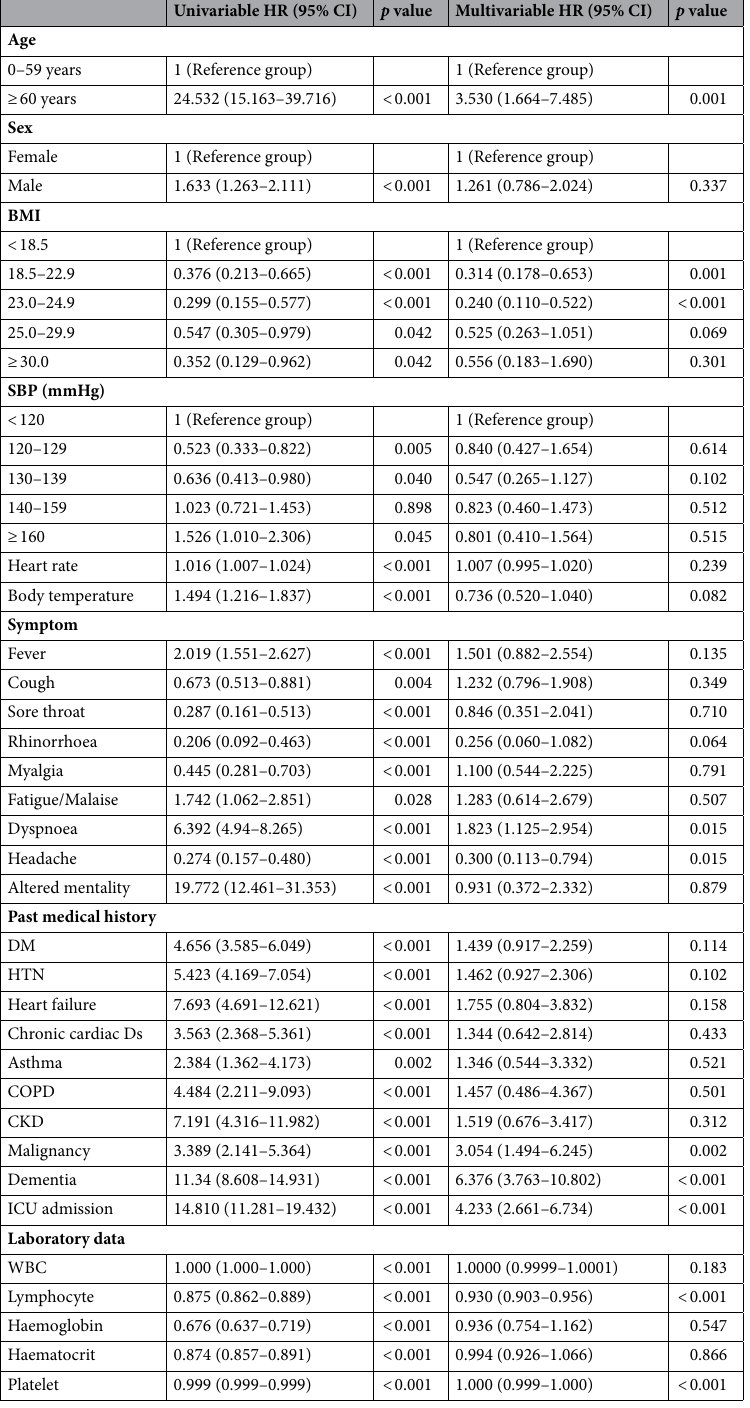
Table 4. Cox proportional hazards model for mortality among COVID-19 patients. COVID-19 coronavirus disease 2019, HR hazard ratio, CI confidence interval, BMI body mass index, SBP systolic blood pressure, DM diabetes, HTN hypertension, Ds disease, COPD chronic obstructive pulmonary disease, CKD chronic kidney disease, ICU intensive care unit, WBC white blood